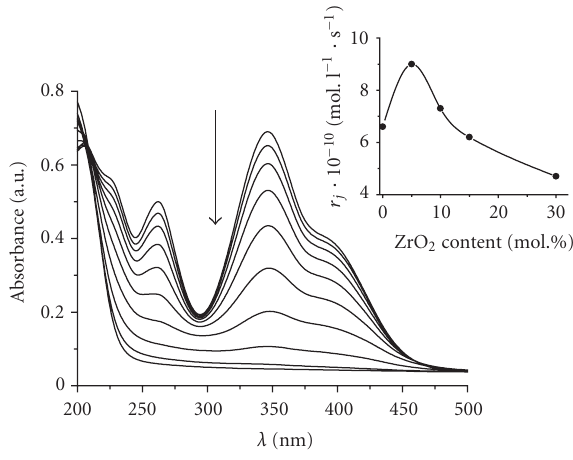
Figure 3: Normalized concentration versus time for Cr(VI) re- duction over TiO 2 films: nonporous - 1, mesoporous - 2, and TiO 2 / ZrO 2 films with 5% - 3 and 30% Zr content - 4 for 20ml of 2 · 10 − 4 M water solution of K 2 Cr 2 O 7 in the presence of EDTA (2 · 10 − 4 M) pH = 2 over 1 film ( m = 0 . 001g), λ irrad . = 254nm, P 0 = 3 · 10 − 7 einstein · dm − 3 · s − 1 .